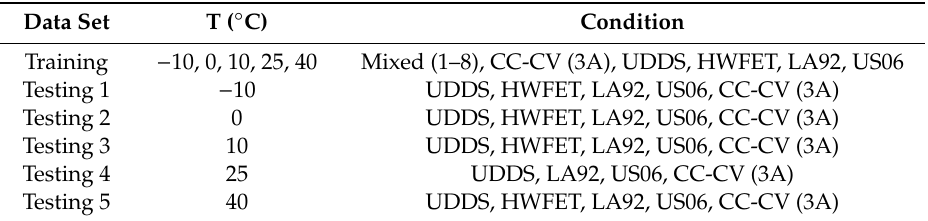
Table 2. The detailed division of training set and test